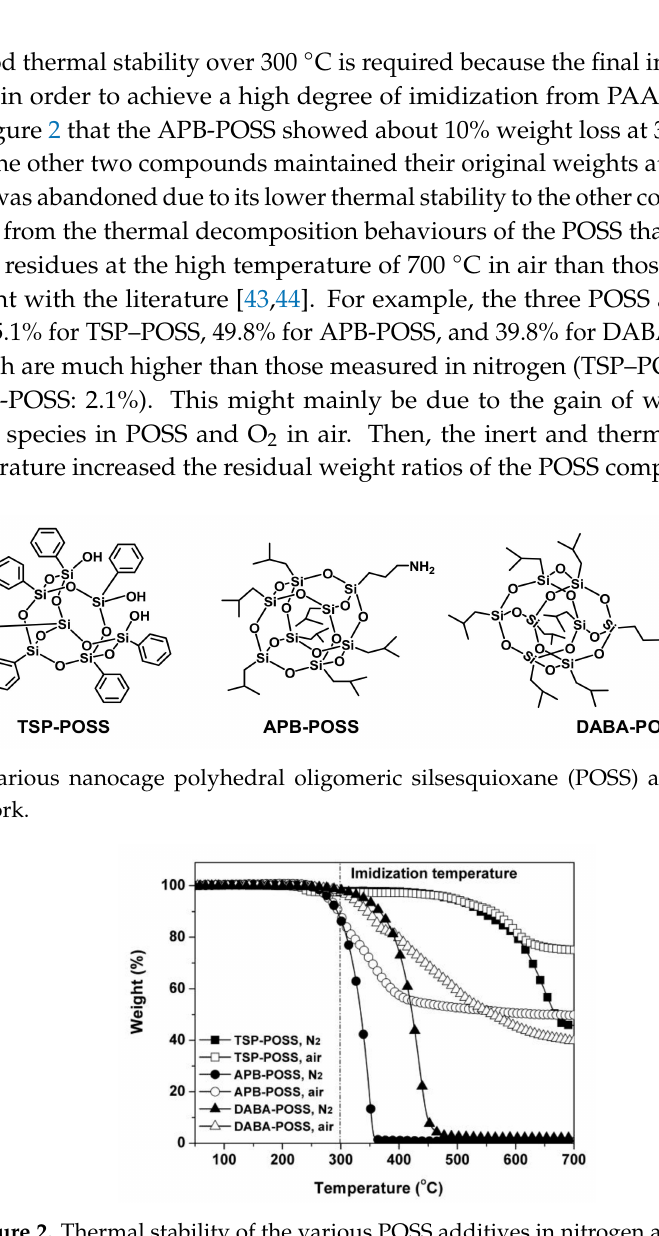
Figure 2. Thermal stability of the various POSS additives in nitrogen and in